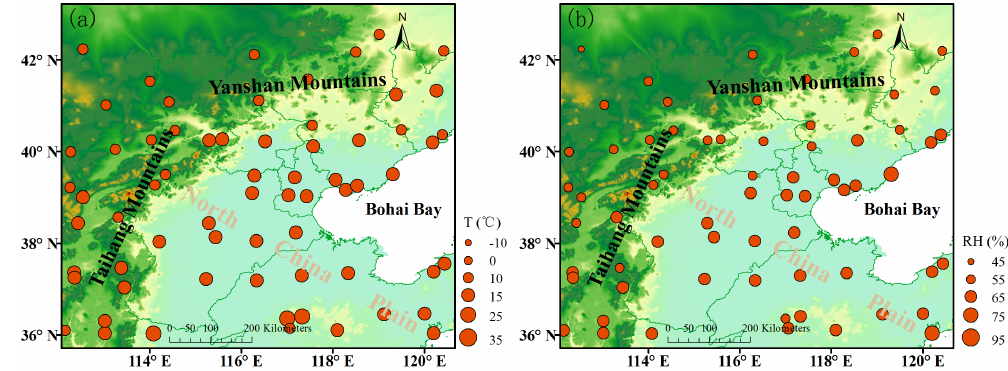
Figure 8. Distribution of annual means of (a) T and (b) RH in the NCP region from December 2013 to November 2014.